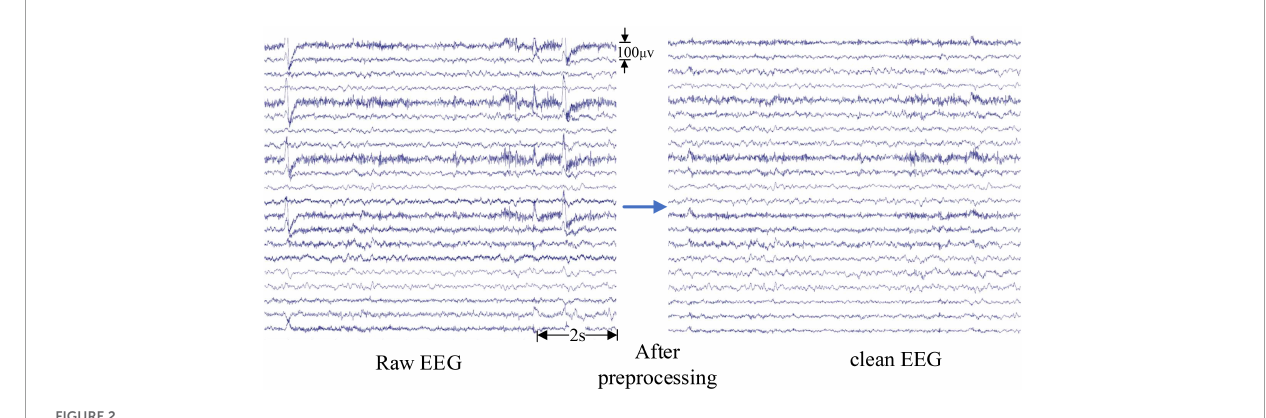
FIGURE2 The clean electroencephalogram (EEG) signals after